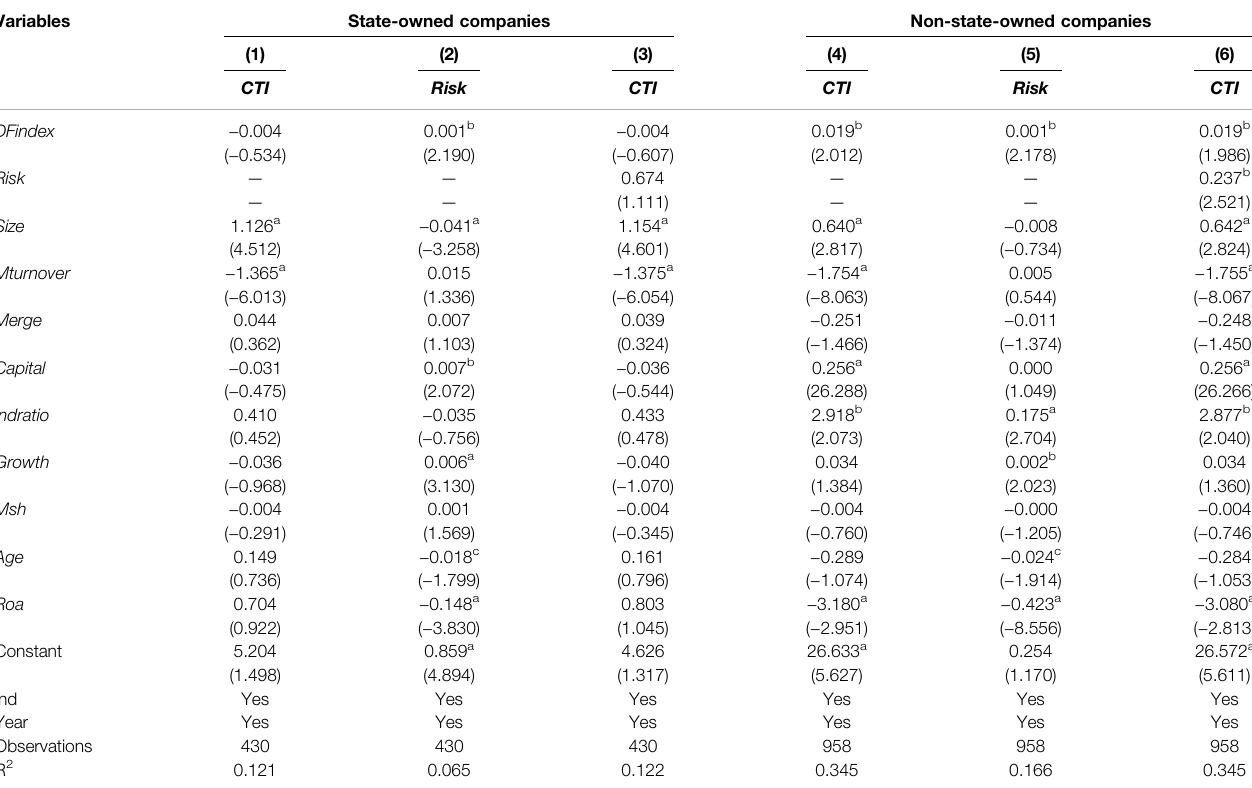
TABLE 6 | Estimations of the moderating effect of property